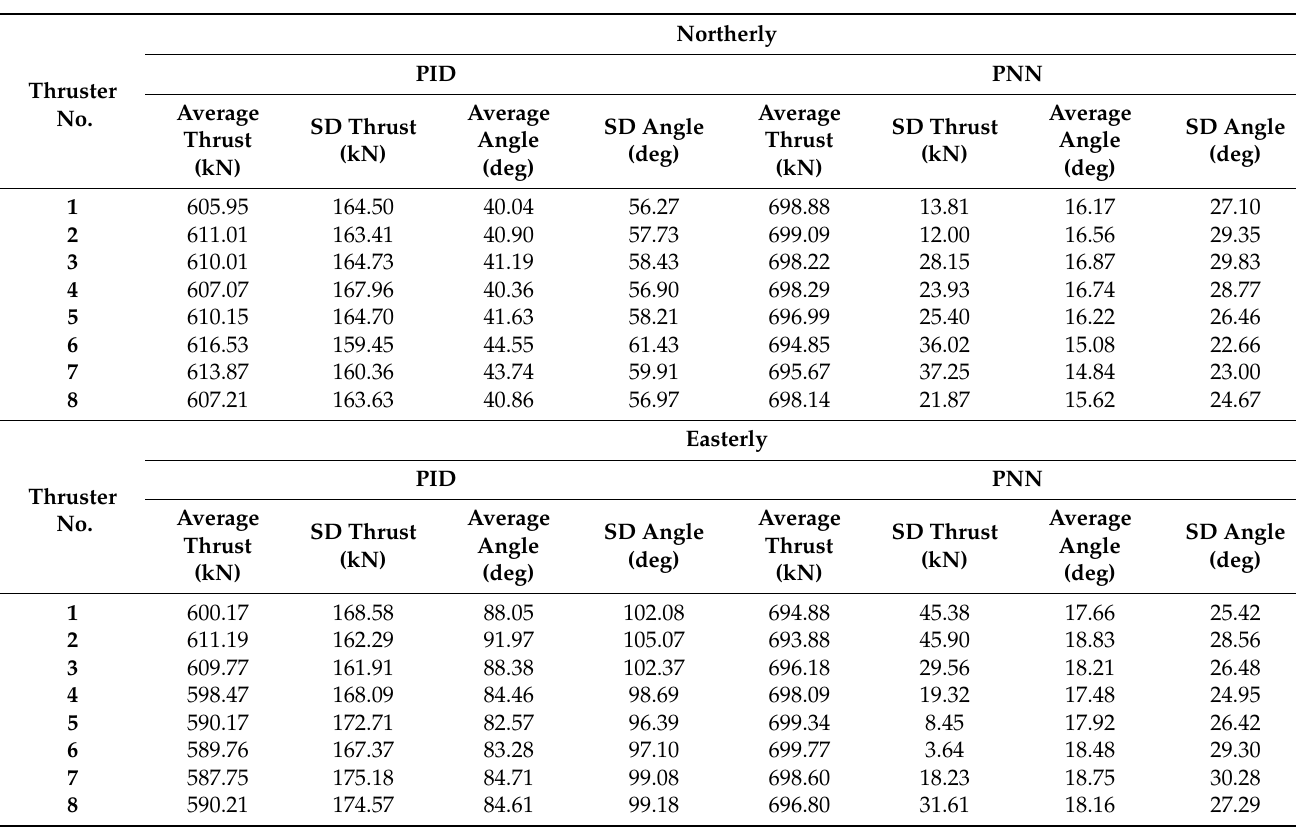
Table 7. Standard average and deviation analysis of Thrusters’ forces and